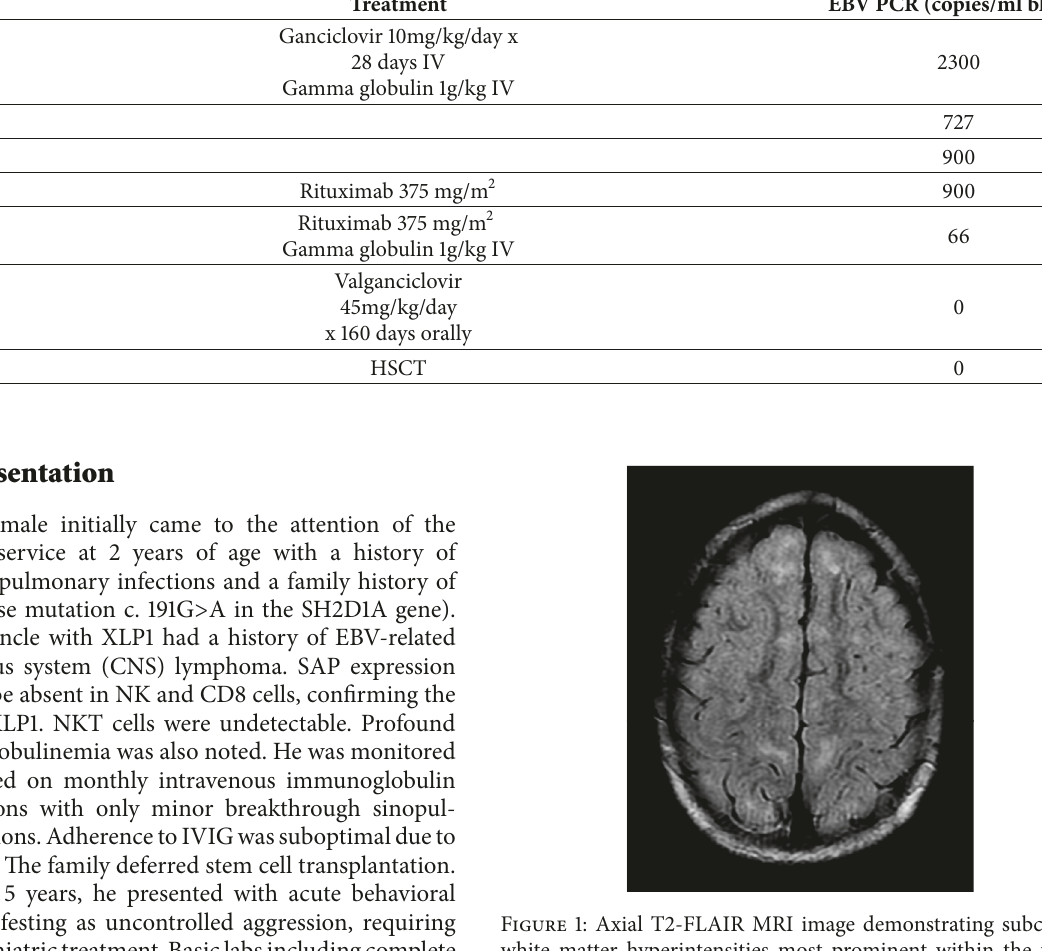
Table 1: Treatment interventions and corresponding EBV counts by PCR from blood samples. Treatment